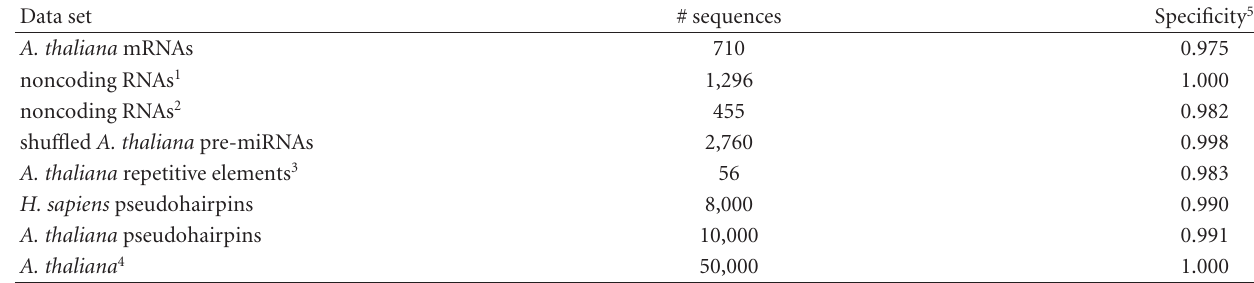
Table 2: Specificity of novoMIR .